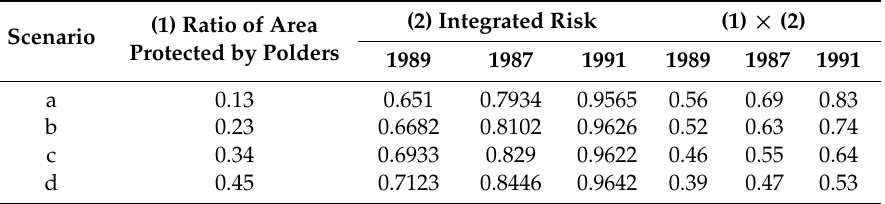
Table 7. Reasonable analysis of different polder combinations.